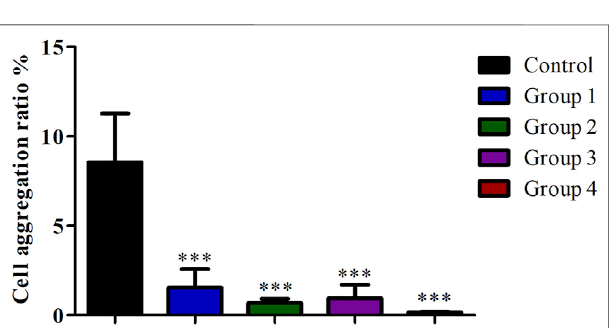
FIGURE 7 | The effect of different cell puri fi cation methods on cell aggregation ratio. Data are presented as means ± SD; *** p value < 0.05.